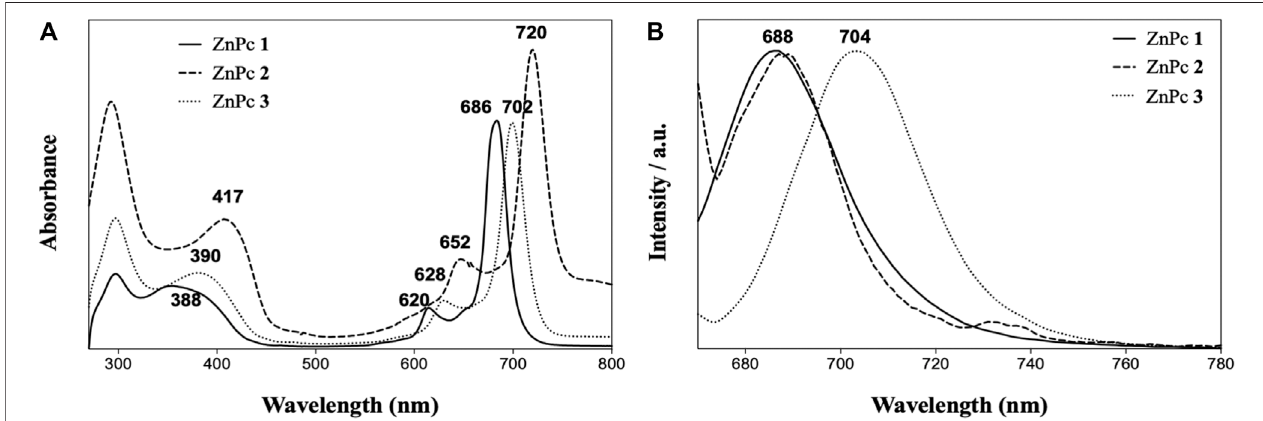
FIGURE 1 | Spectra of (A) UV – Vis absorption and (B) normalized emission ( λ exc. = 660 nm) of ZnPcs 1 – 3 in